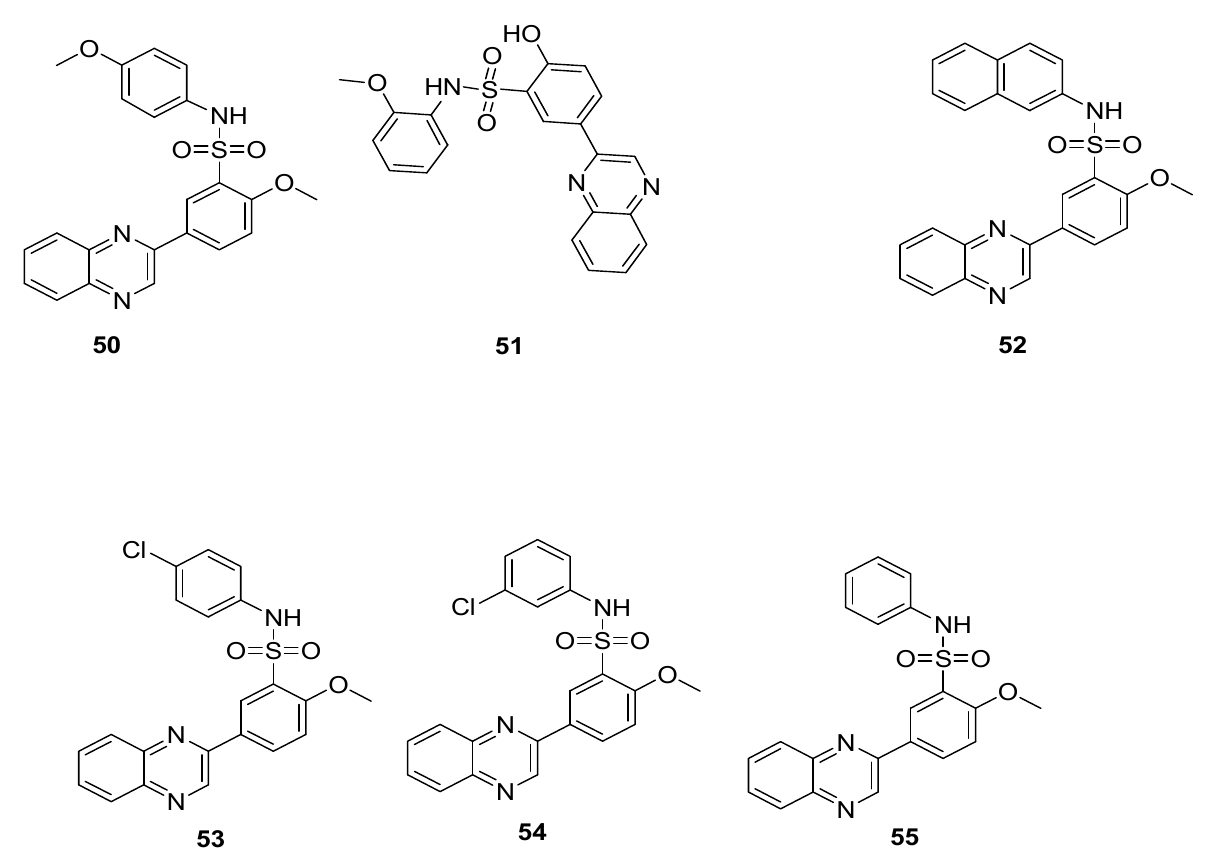
Figure 8. Substituted quinoxaline benzene sulfonamide derivatives 50–55. Table 2. Antibacterial activity of quinoxaline benzene sulfonamide derivatives 50–55 .